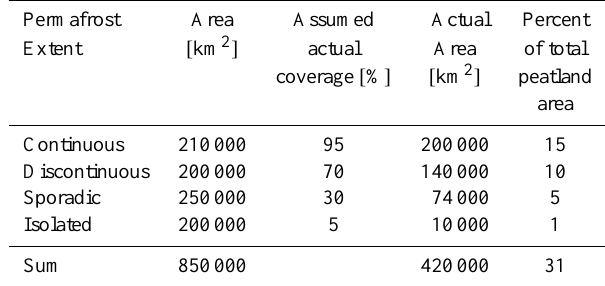
Table 3. Contemporary geography of peatlands and permafrost ex- tent in Alaska and Canada. Percentages relative to the total peatland area in Alaska and Canada (1.40millionkm 2 ) . Permafrost classifi- cation from Brown et al.